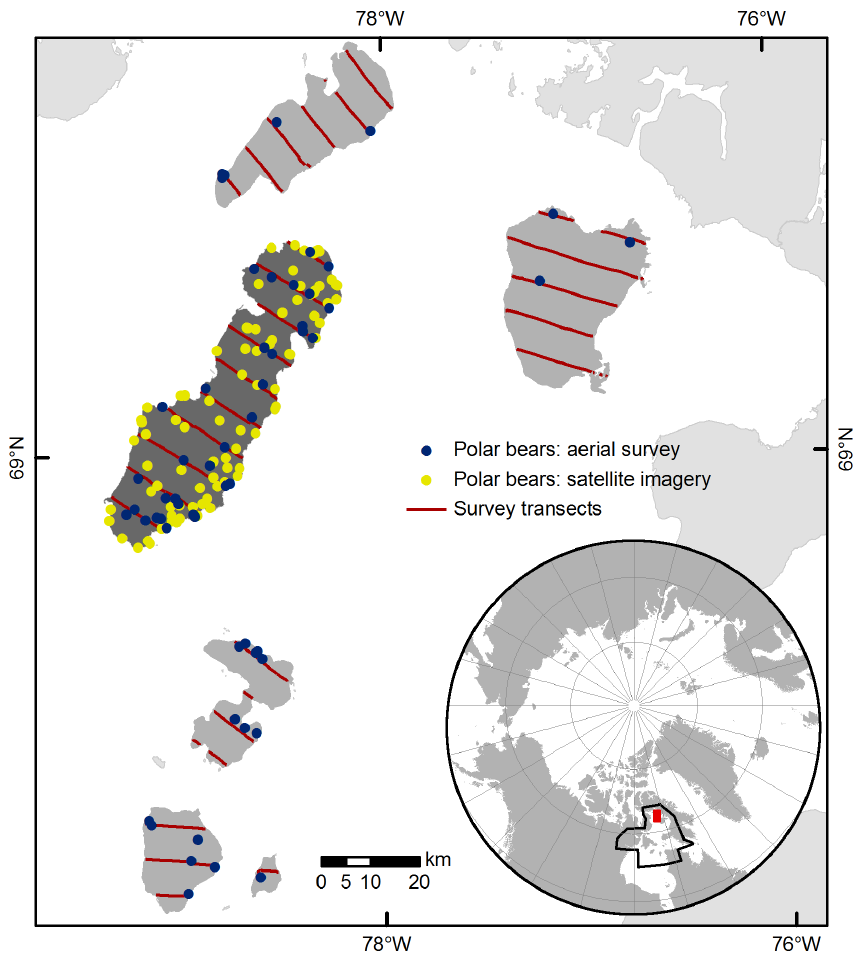
Figure 1. Polar bears detected with high resolution satellite imagery and during the helicopter-based aerial survey. Target imagery was acquired from Rowley Island (dark shade) in northern Foxe Basin, Nunavut with the WorldView-2 and Quickbird satellites on September 3, 2012. Transects were spaced at 7 km intervals during the aerial survey. The Foxe Basin polar bear subpopulation is outlined in black and the study area is shaded red in the inset.